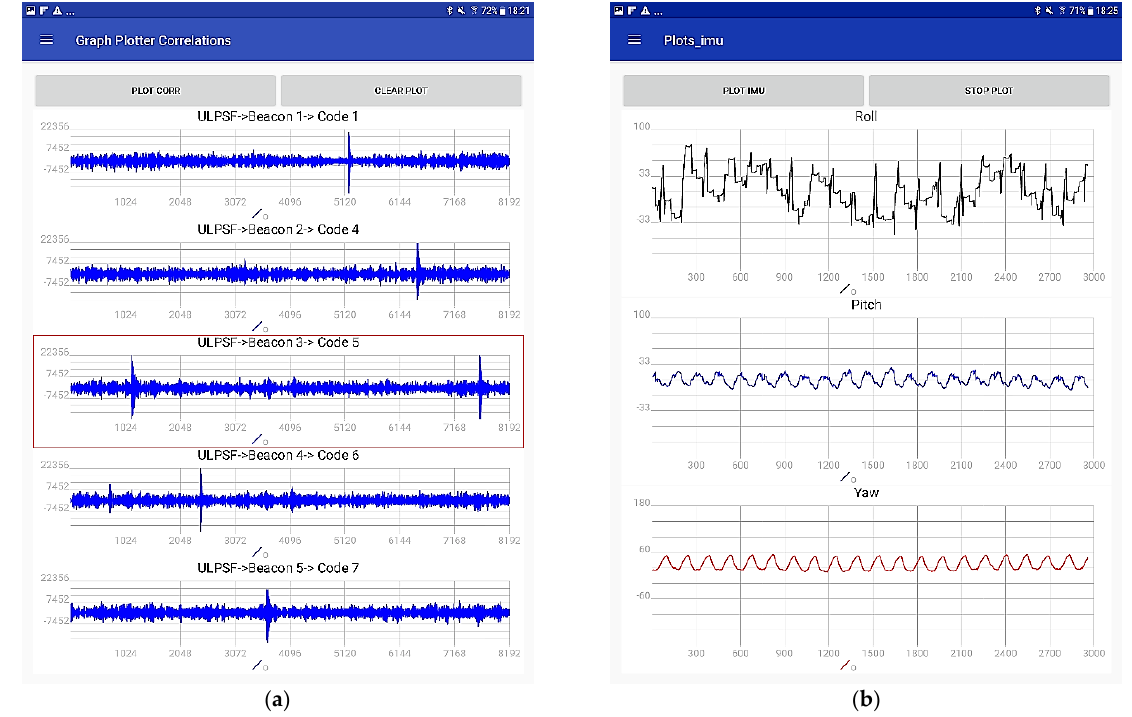
Figure 16. Additional screens in DEBUG mode. ( a ) US correlations, ( b ) IMU raw data.